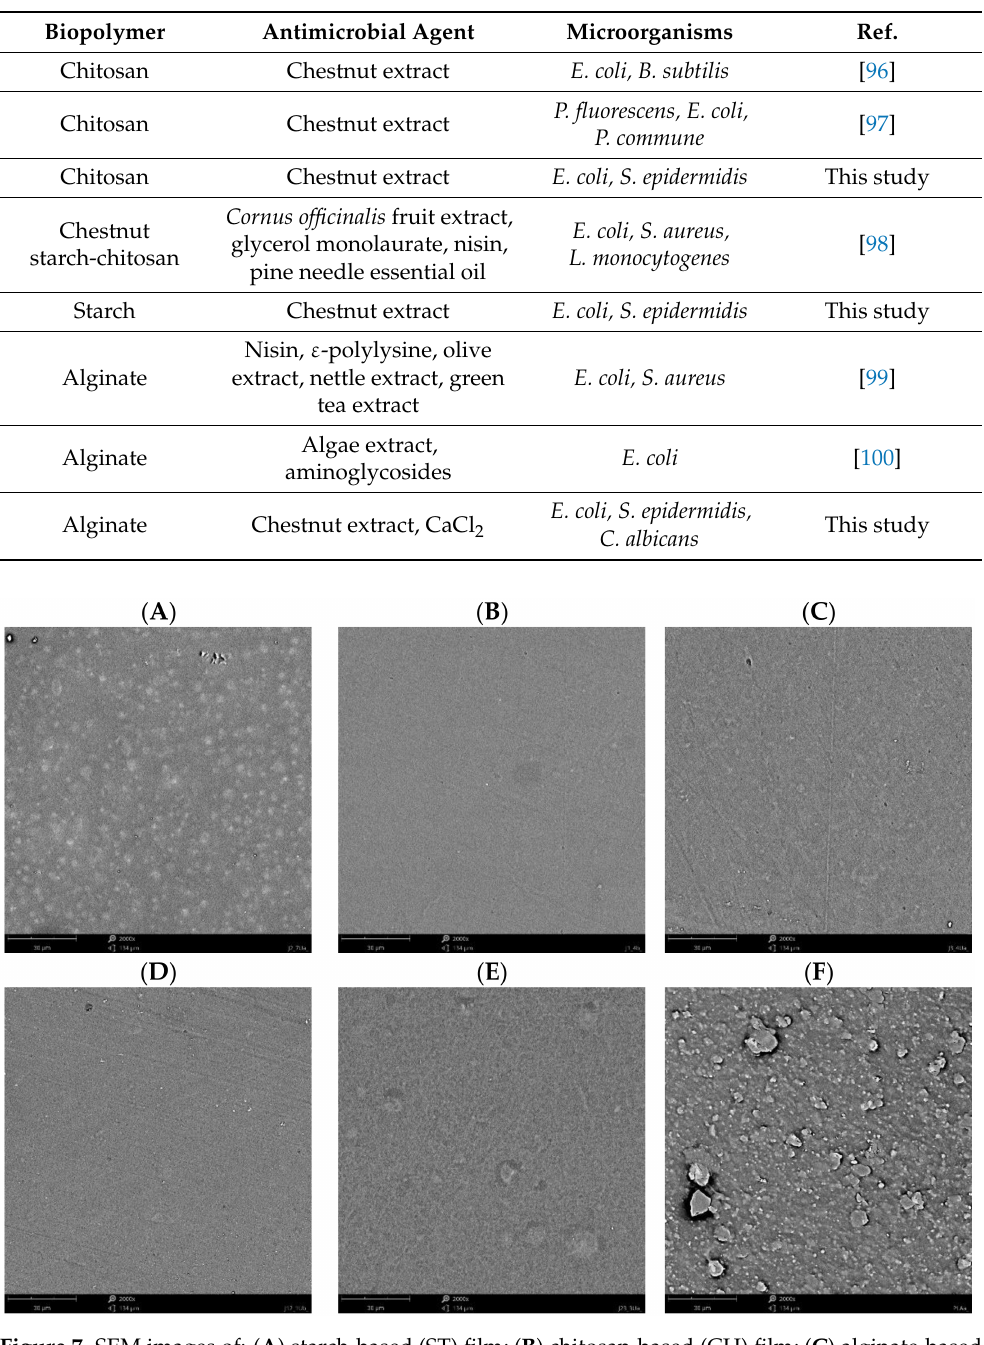
Table 2. Polysaccharide-based films containing different plant extracts exhibiting antimicrobial activity towards particular microorganisms.